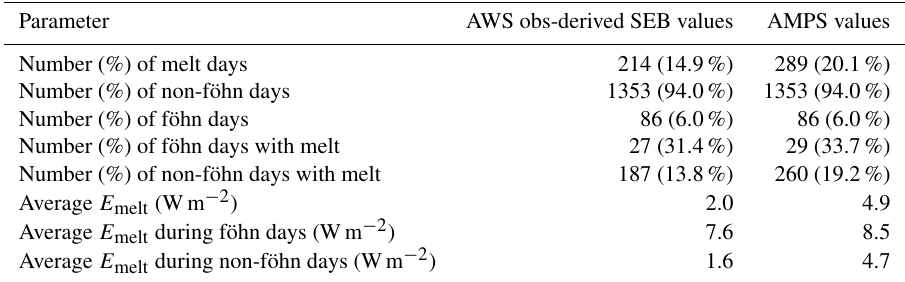
Table 3. The representation of surface melt from observation-derived data at AWS2, alongside AMPS model output interpolated to the same location. The total number of days with observations for 2009 to 2012 is 1439, which is used for the calculation of percentages for rows 2–4. The average E melt values are daily averages over the same period. The total number of föhn and non-föhn days are the same for both AWS and AMPS as a result of the föhn identification (Sect. 2.4): föhn conditions must be identified in both to be classified as föhn. The number of föhn and non-föhn days are the same in AWS and AMPS as this was a criterion for the detection of föhn winds in Turton et al. (2018).